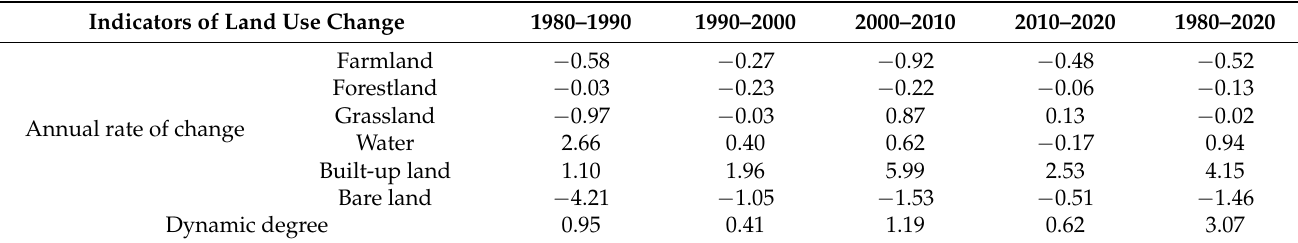
Table 5. The annual rate of change (%) for six land use types and the dynamic degree (%) for the whole study area. Indicators of Land Use